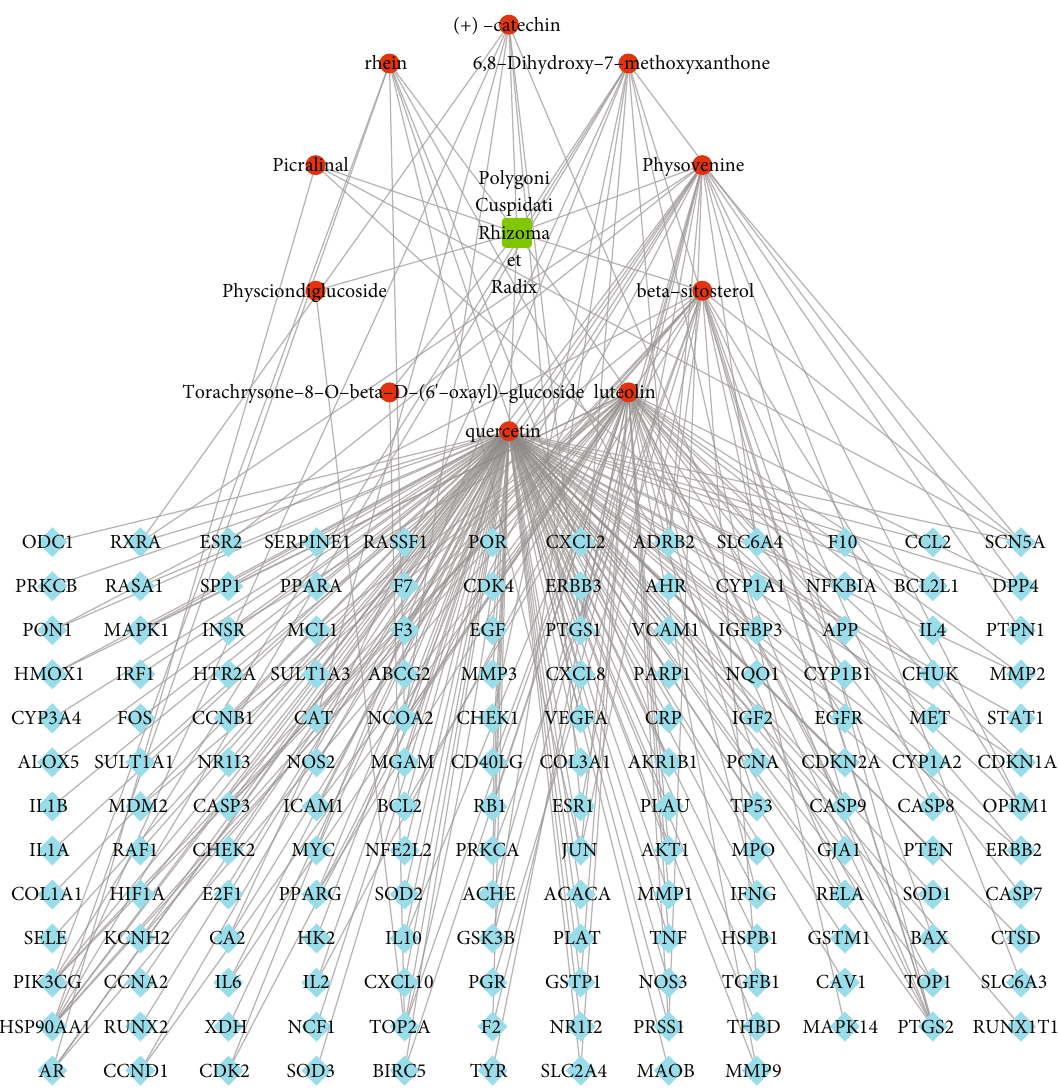
Figure 3: Drug-components – target genes network. The red circle nodes represent the bioactive components of Polygoni Cuspidati Rhizoma et Radix (PCRR), the blue diamond-shaped nodes represent the candidate targets, and the green square represents